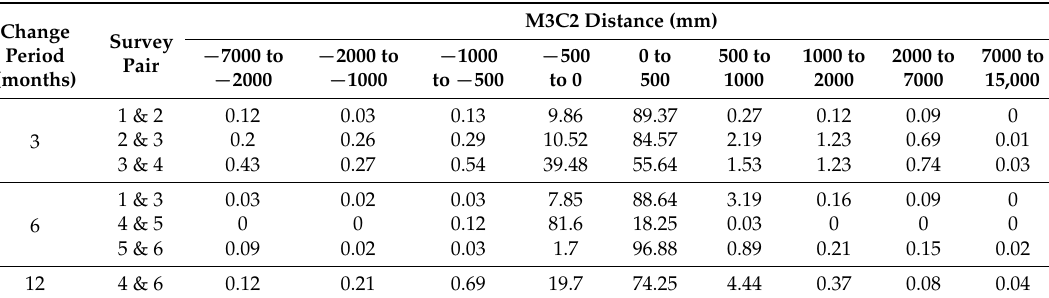
Table 3. Proportions of total number of significant points in M3C2-PM change rasters between pairs of surveys. Rasters were created from change clouds at a resolution of 0.75 m, with the mean of intersecting points in horizontal space assigned as the value in each